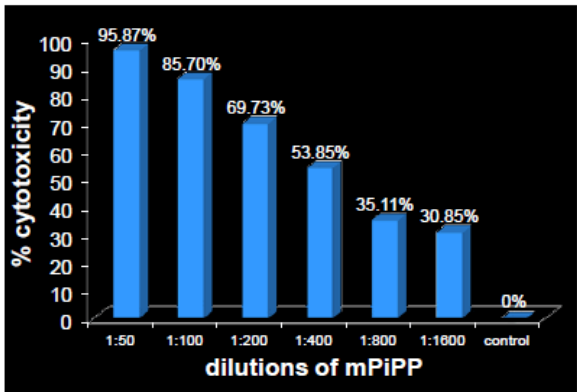
Figure 7. Dose-dependent cytotoxicity exercised by the monoclonal anti-hCG-antibody PiPP on lung cancer cells (A549) Note . Reprinted from “Immuno-Interception of Human Chorionic Gonadotropin has Two Applications of Extraordinary Utility” by Talwar GP, Gupta JC. Perceptions Reprod Med. 2019;3:PRM.000565 (http://dx.doi.org/10.31031/prm.2019.03.000565). © 2018 Talwar